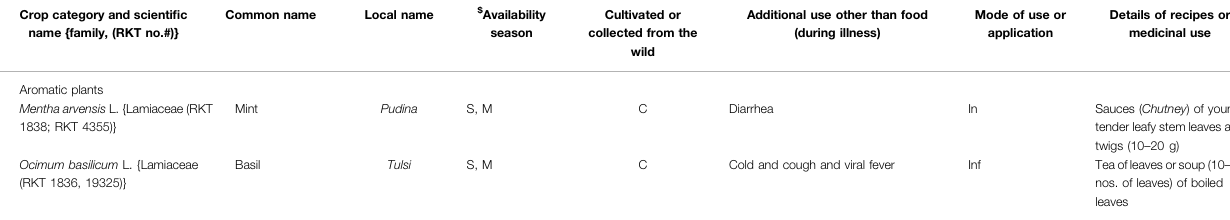
TABLE 1 | ( Continued ) Crops plants used as traditional foods, nutritional security, and primary healthcare by central Himalayan